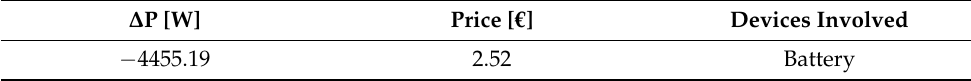
Table 4. Winner offer at 12:00.